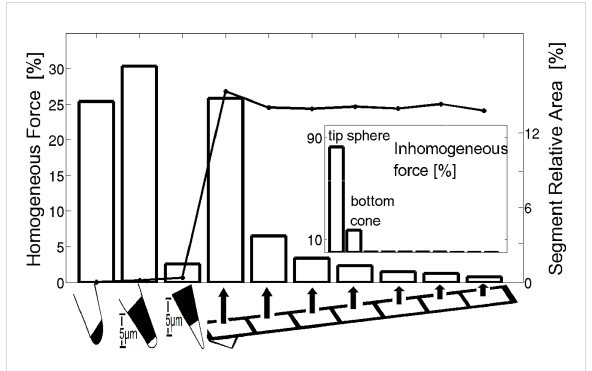
Figure 3: Left axis: Relative magnitude of the homogeneous force distribution on different fractions of the probe; right axis: The relative area percentage of each of the segments. The graph was calculated for β = 20° with a probe–sample distance of d = 17.8 nm. The probe was divided into ten segments (presented from left to right) – the bottom sphere, the bottom part of the cone (vertical length of 5 µm), the top part of the cone (vertical length of 5 µm) and seven segments of the cantilever each with an horizontal length of 26.7 µm (the outer most segment of the cantilever does not include any part of the cone). The inset figure represents the relative inhomogeneous force for each segment as a percentage of the total inhomogeneous force on the